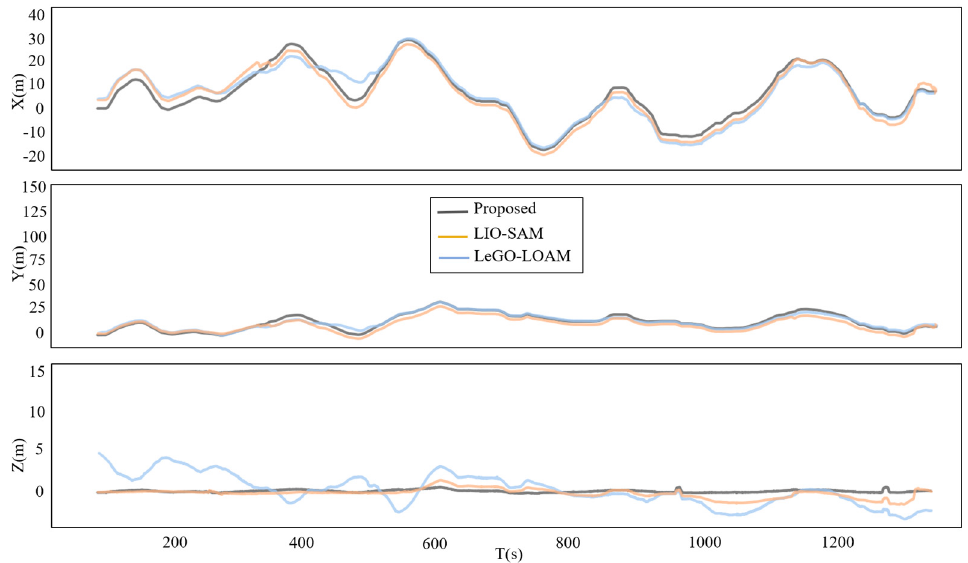
Figure 12. The relative error of trajectory in three-axis direction.